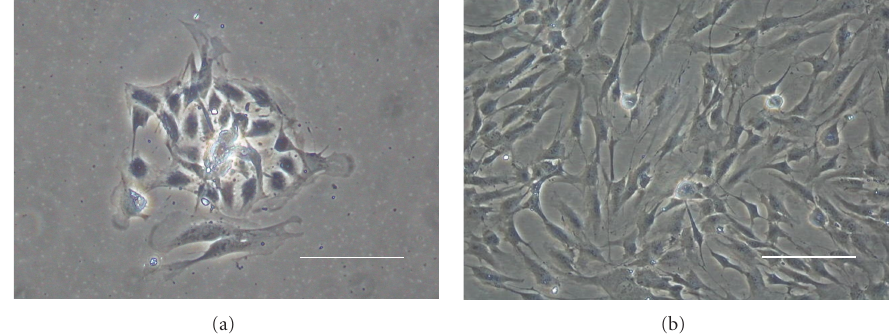
Figure 1: Phase contrast micrograph of DPSCs in culture. (a) Small colonies (CFU-F) formed by DPSCs appeared in primary culture after 3 days in vitro. (b) Spindle-shaped morphology of cells in culture reaching 70% confluence. Scale bars 50 μ